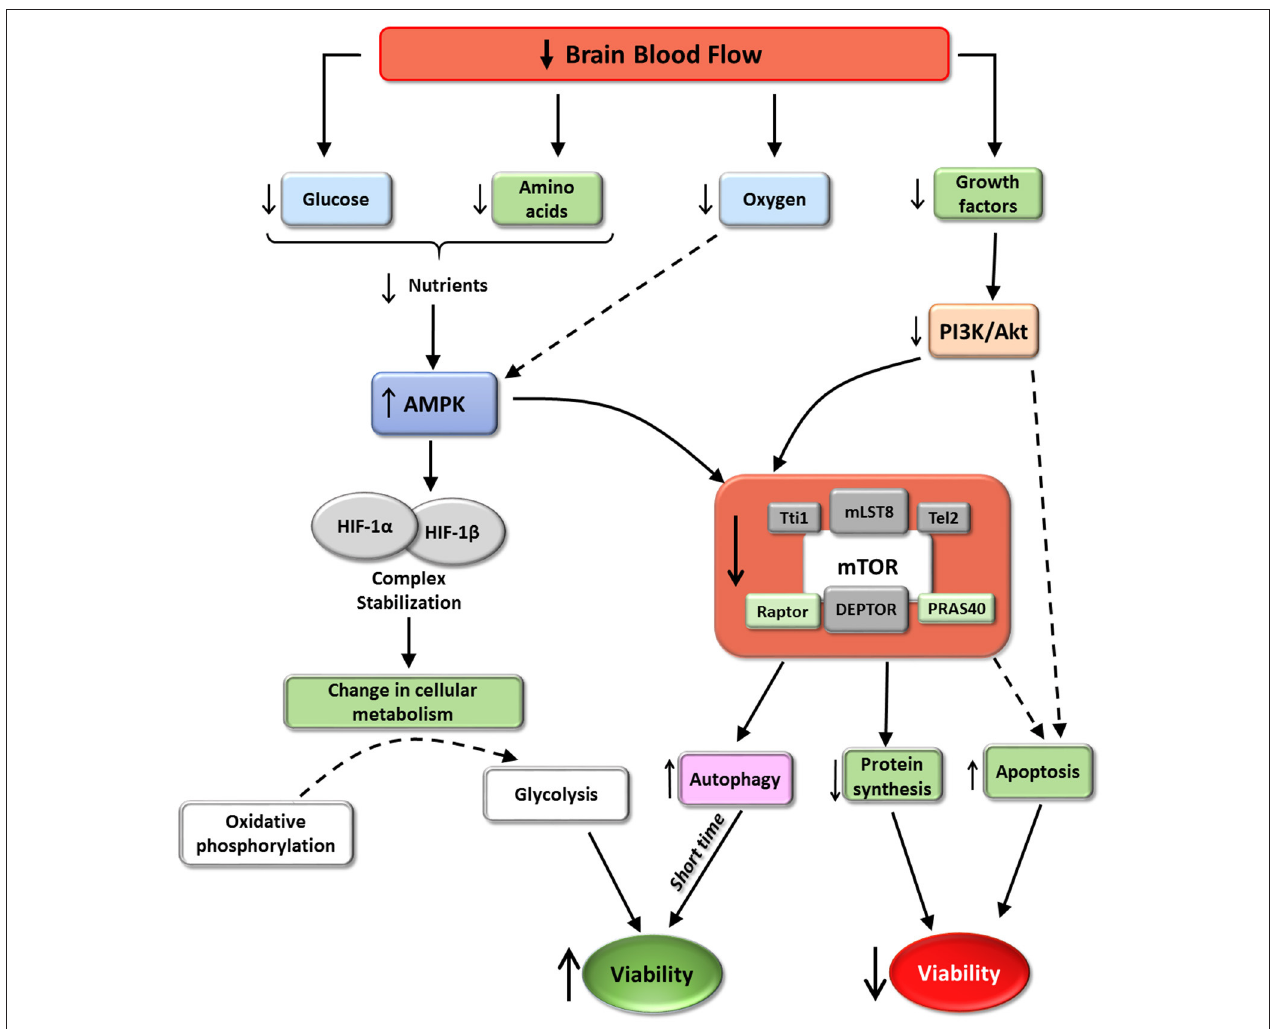
FIGURE 5 | mTORC1 and cerebral ischemia. The scheme represent some of the effects of cerebral ischemia on mTORC1 activity according with the available data. Ischemia induces mTORC1 inhibition. These situation promotes a reduction in protein synthesis and an increase autophagy and in some situations apoptosis. The increment in autophagy, almost at short time, may induce an increment in cell viability. However, autophagy imbalance or ischemic persistence may trigger apoptosis. The balance of this process via mTORC1, determinates the final destiny of hypoxia affected cells.